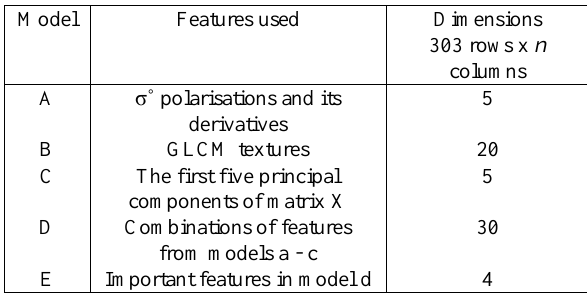
Table 4. Summary of models and respective features Using the optimum hyper parameters of RF, the accuracies (r 2 ) and the RMSE for each model were determined (see Table 5).